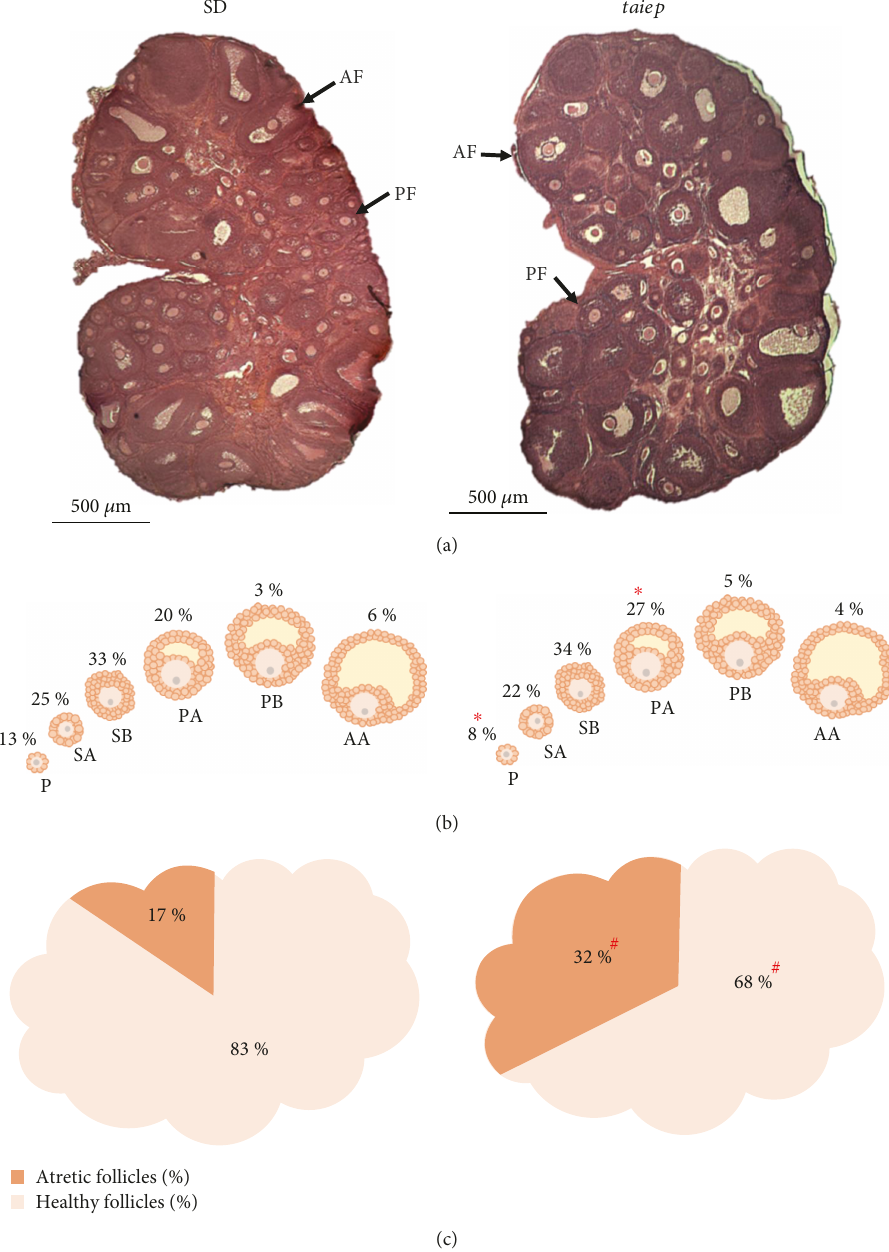
Figure 3: Follicle population in Sprague – Dawley and taiep rats in the juvenile stage. (a) Representative histological slice of the ovary. (b) Percentages of follicles in the di ff erent categories. (c) Percentages of total atretic and healthy follicles in the ovary. SD: Sprague –